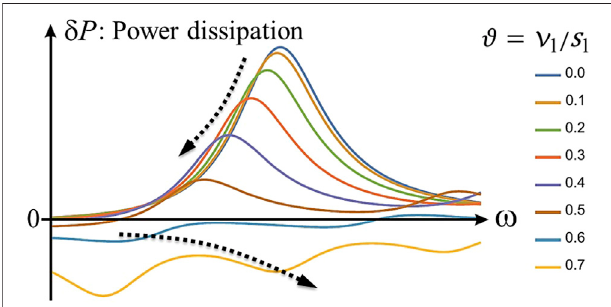
FIGURE 6 | Calculated power dissipation in the active region 1 for different values of ϑ (cid:1) v 1 / s 1 [47]. The dotted arrow lines indicate the tendency of red shifting in the absorption regime and blue shifting in the ampli fi cation